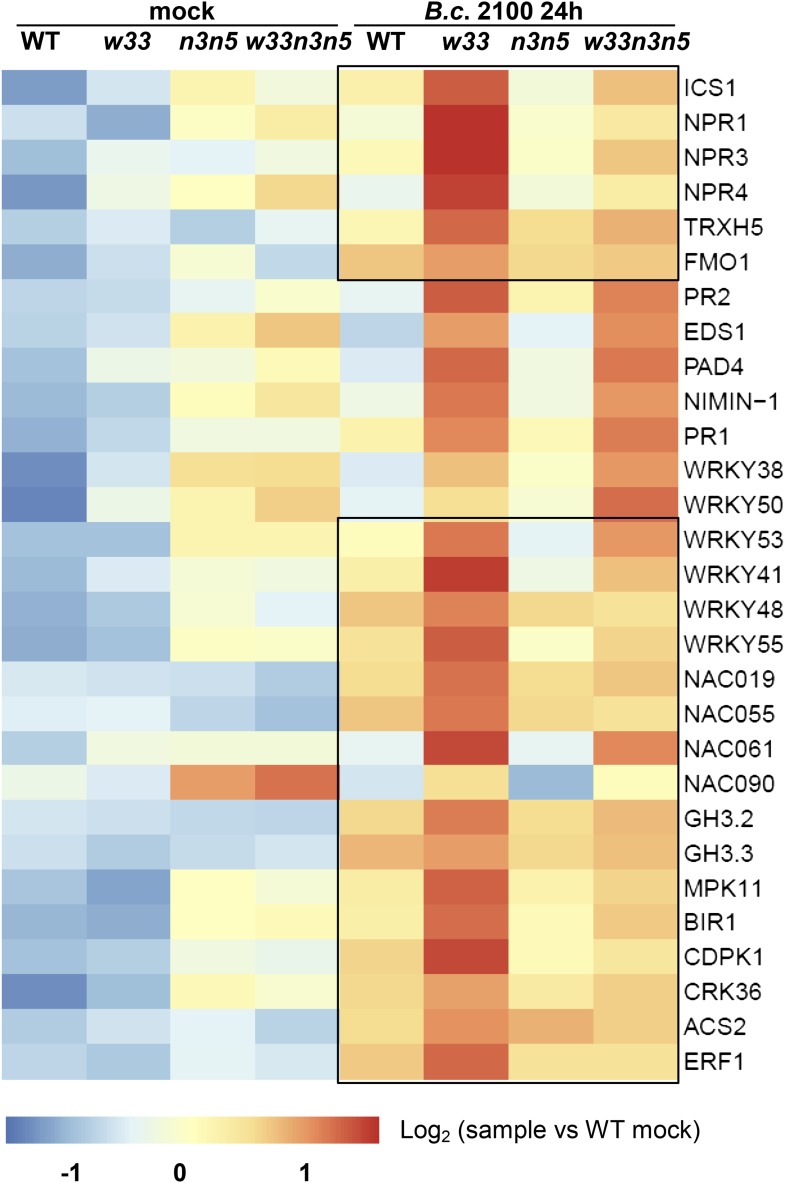
Expression of numerous genes up-regulated in infected wrky33 plants showing WT-like levels in the wrky33 nced3 nced5 triple mutant.Heatmap showing expression levels of genes, differentially expressed in RNA-seq and analyzed by qRT-PCR in WT, wrky33 (w33), nced3 nced5 (n3n5), and wrky33 nced3 nced5 (w33n3n5) after mock treatment or 24 hr post B. cinerea (B.c. 2100) infection. Genes showing high expression levels in wrky33 but reduced levels in the triple mutant are boxed. All values were normalized to the expression of At4G26410.